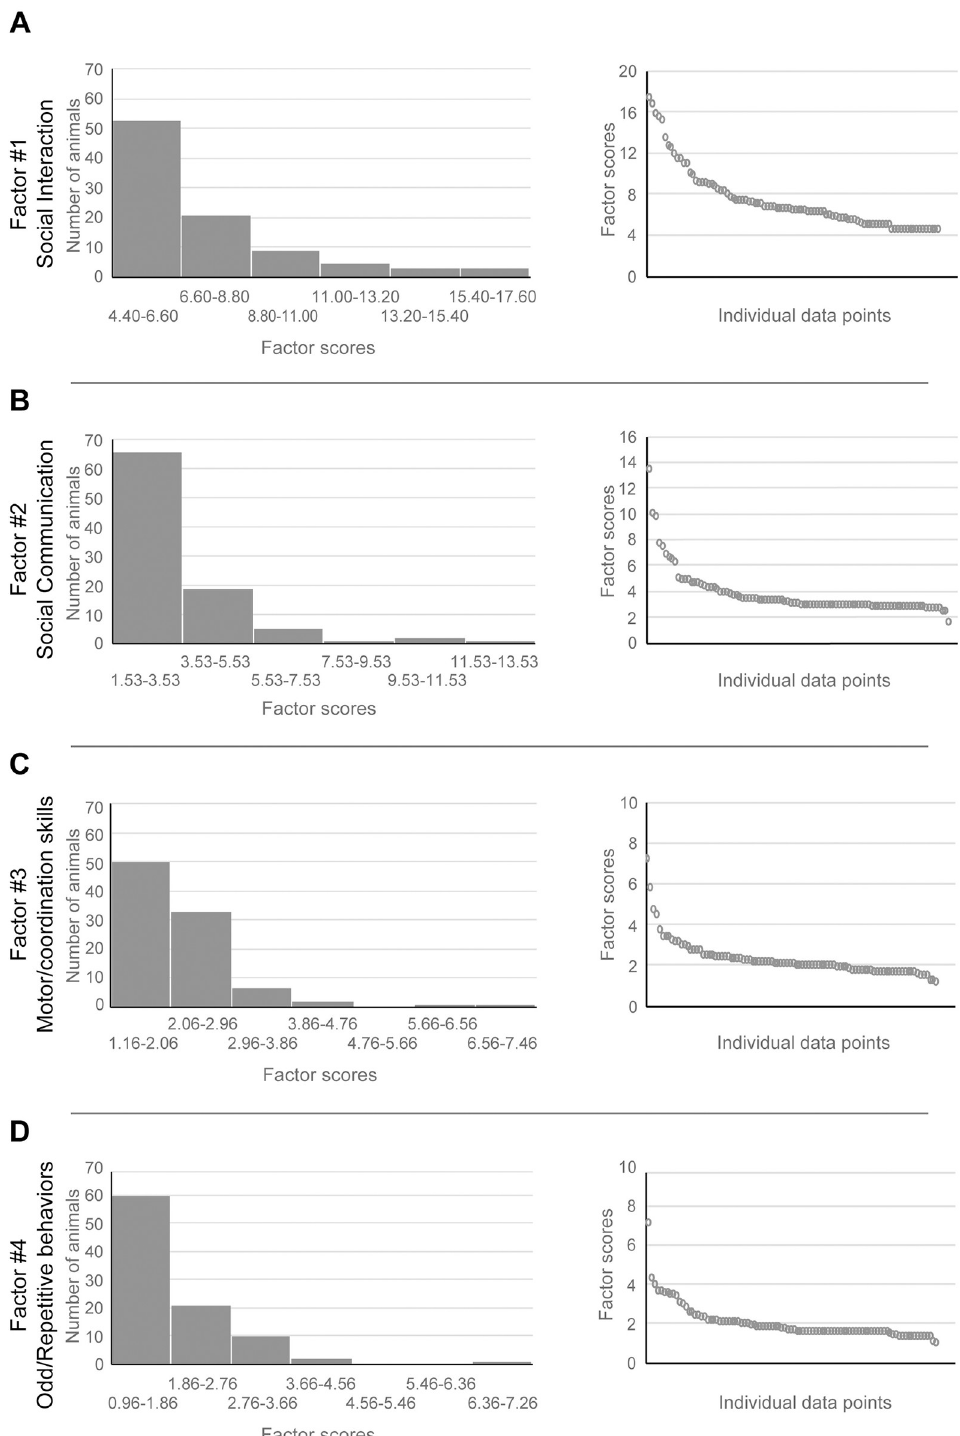
Fig 2. JmSRS EFA factors scores distributions. Left : Histograms showing frequency distribution of jmSRS Factors #1, #2, #3 and #4’s scores (calculated by multiplying the item score by the factor loading per subject) in our juvenile macaque population. Right : Individual Factor scores, each circle represents a subject (n = 93). A) jmSRS Factor #1 (Social interaction); B) jmSRS Factor #2 (Social communication); C) jmSRS Factor #3 (Impaired motor coordination, staring off into space); D) jmSRS Factor #4 (Repetitive/Odd